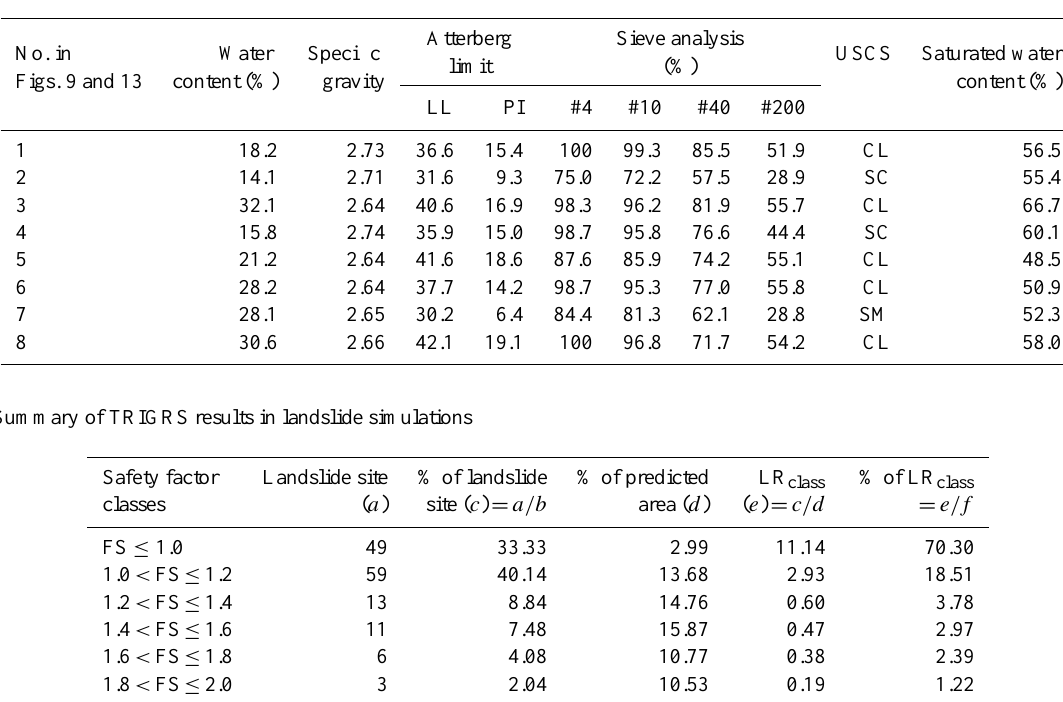
Table 3. Summary of geotechnical laboratory results. CL is Lean clay, SC is Clayey sand and SM is Silty sand. No. in Water Specific Figs. 9 and 13 content (%) gravity